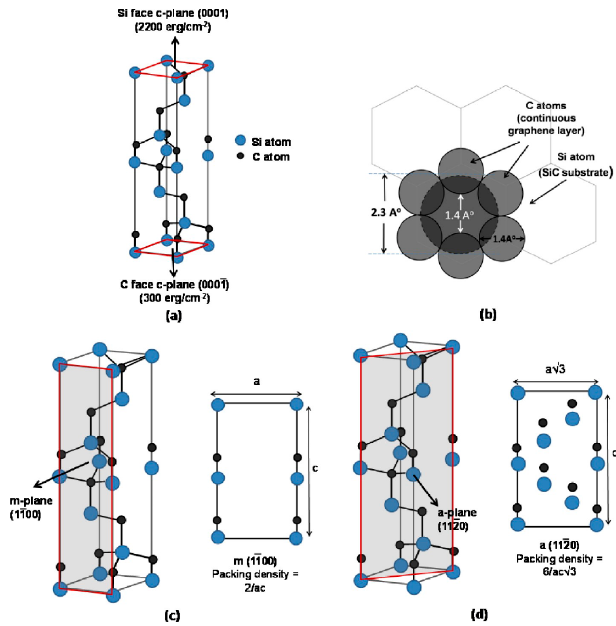
Figure 32. ( a ) Unit cell of 6H-SiC. ( b ) Continuous EG formation on the Si face. Packing density calculation on ( c ) m-plane, ( d ) a-plane of the 6H-SiC crystal. The packing density on the a-plane is